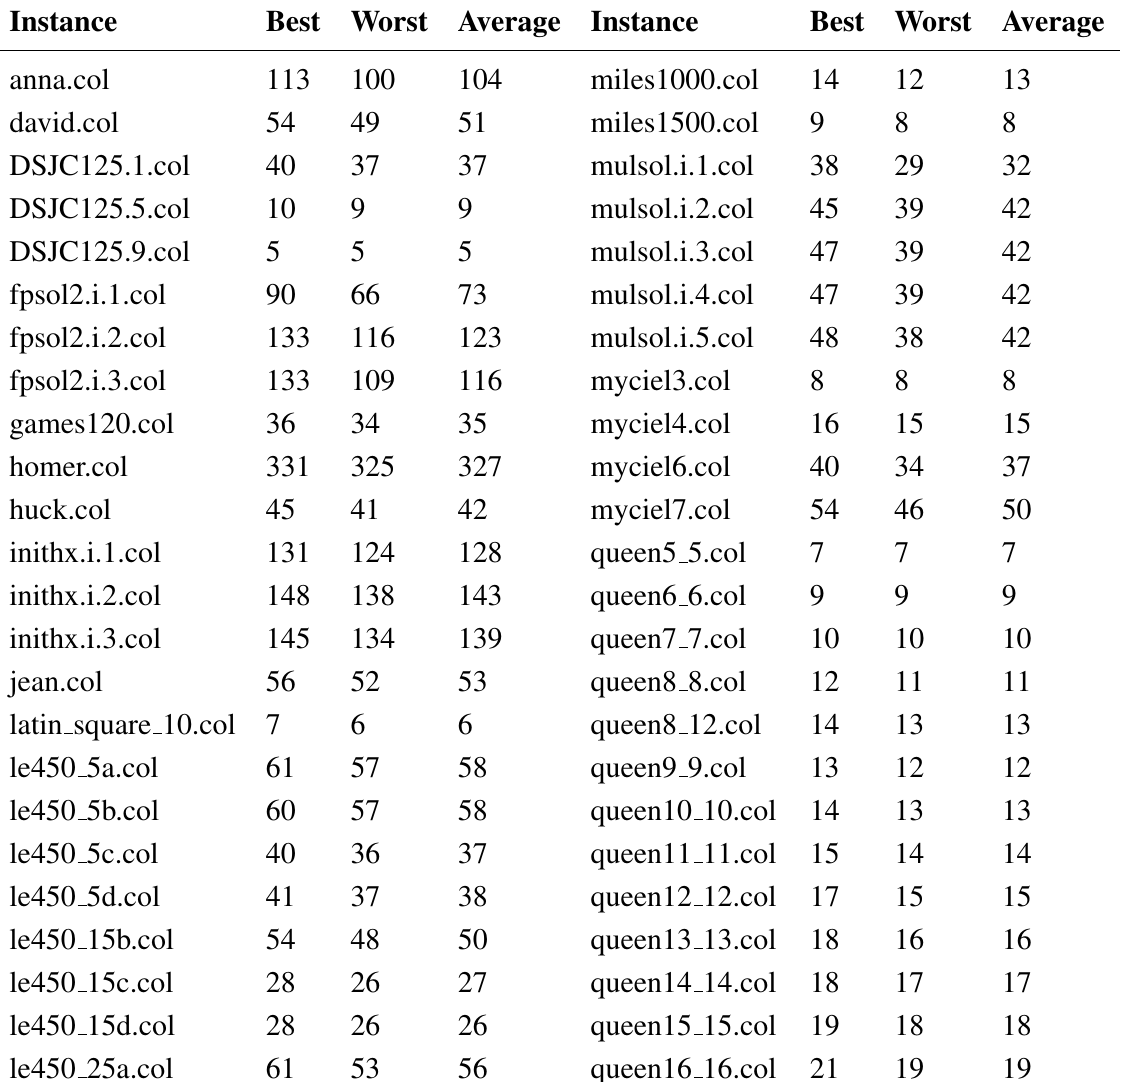
Table 7. Results for simulated annealing (SA) and a CPU-time limit of 30 min for 15 runs.